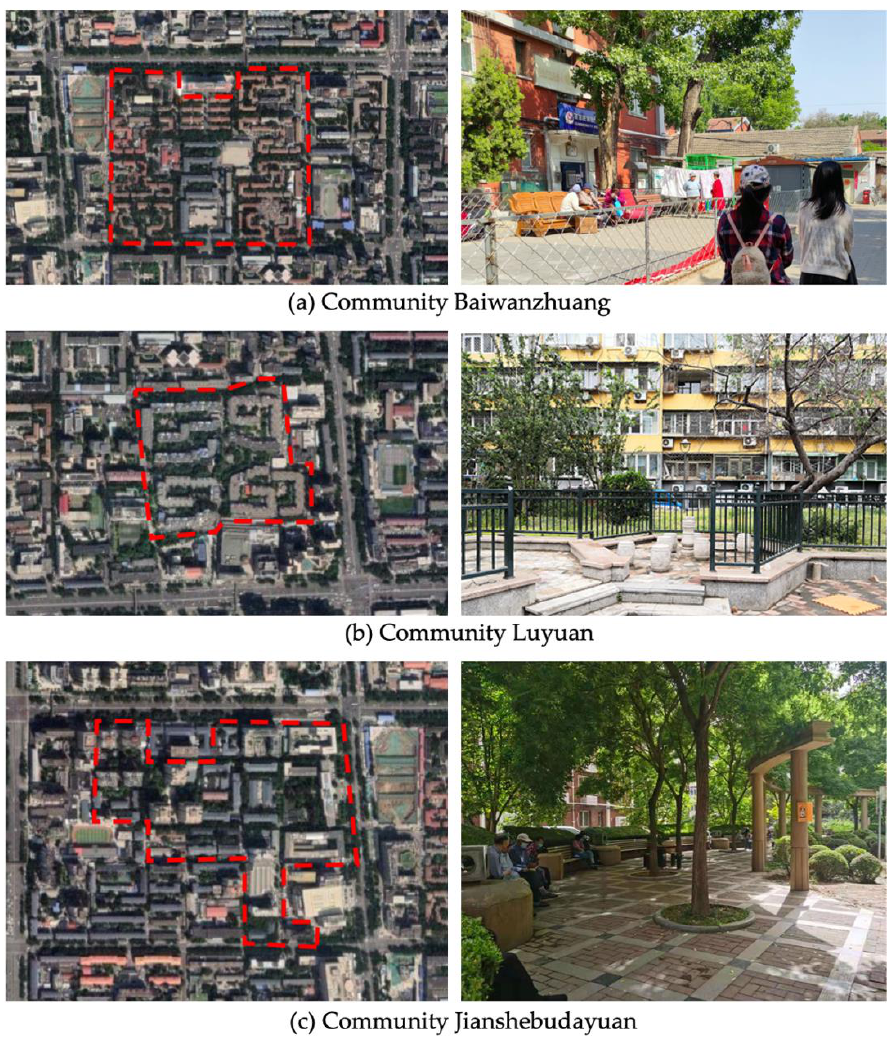
Figure 1. Maps and photos of communities.